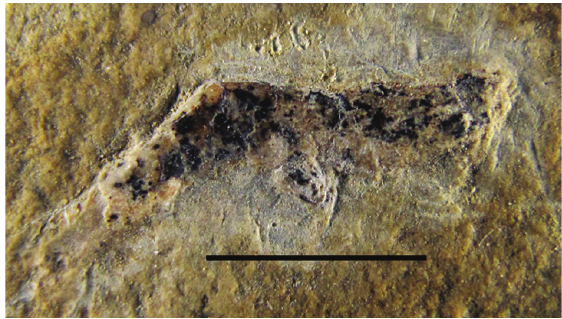
Figure 3 - Lateral view of Kellnerius jamacaruensis (MCNHBJ 339) from Romualdo Formation, Araripe Basin, Brazil. Scale bar: 5